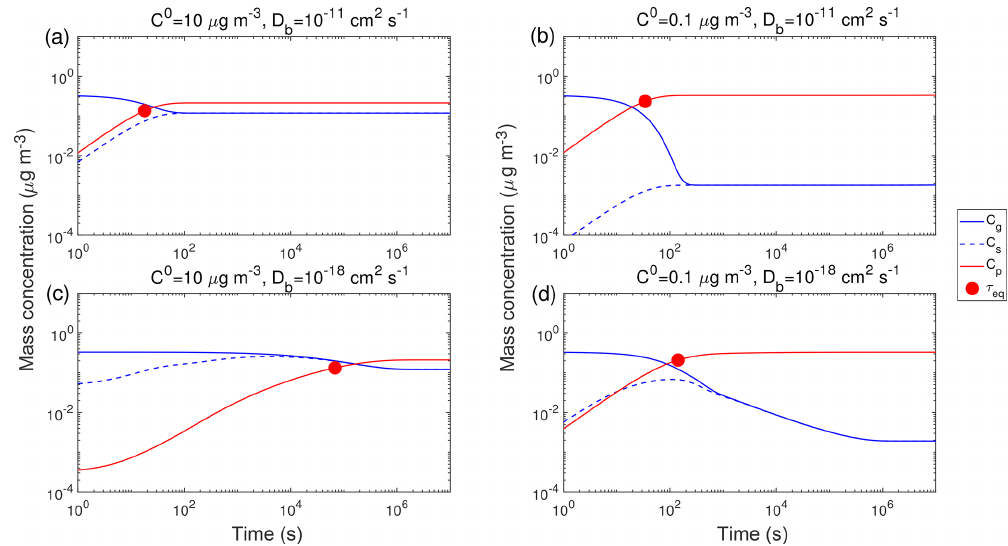
Figure 2. Temporal evolution of mass concentrations of the condensing compound Z in the gas phase ( C g ), just above the particle sur- face ( C s ), and in the particle phase ( C p ) in the closed system. τ eq is marked with the red circle. RH is 60% and T is (a, b) 298K and (c, d) 250K. The C 0 of Z is (a, c) 10µgm − 3 and (b, d) 0.1µgm − 3 . The glass transition temperature of preexisting particles under dry conditions ( T g , org ) is set to 270K, which leads to D b of (a, b) 10 − 11 cm 2 s − 1 and (c, d) 10 − 18 cm 2 s − 1 . The initial mass concentration of preexisting particles is set to 20µgm − 3 with the number concentrations of 3 × 10 4 cm − 3 and the initial particle diameter of 100nm.